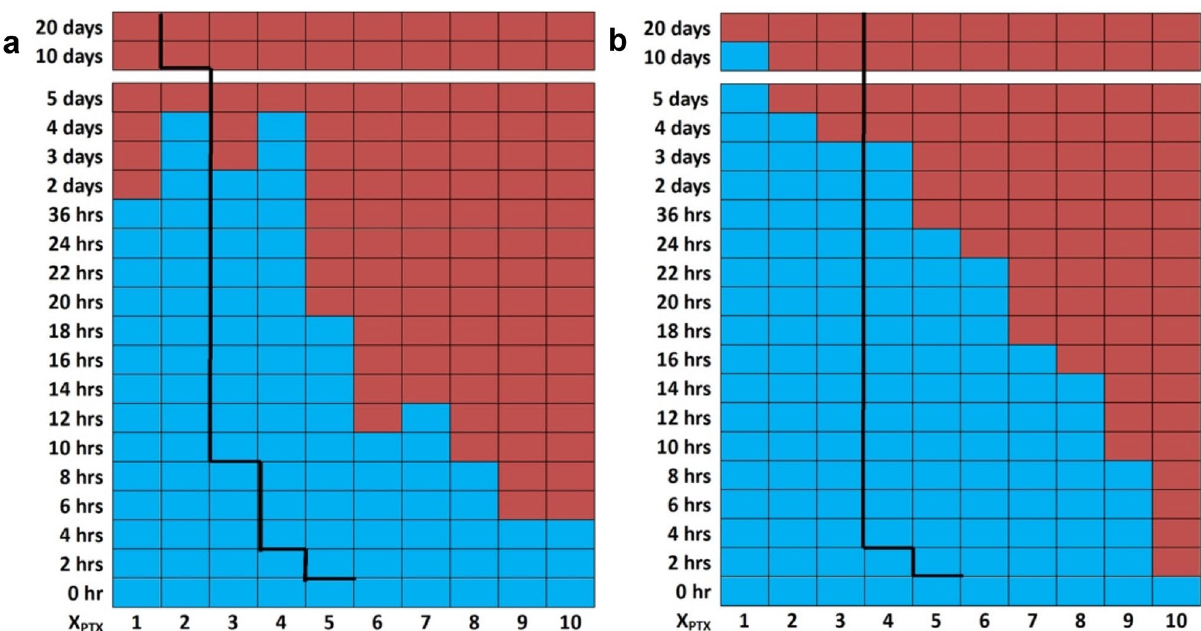
Figure 4. Kinetic phase diagrams of PTX solubility in PTX-loaded CLs with DLin (di-linoleoyl, C18:2) lipid tails (DLinTAP/DLinPC/PTX mole ratio = 50/50–x PTX /x PTX ). DIC microscopy (Fig. 3) was used to detect PTX crystallization at the indicated times after hydration. The blue color indicates absence of PTX crystals (i.e., PTX remained soluble in the membranes), while the red color indicates presence of PTX crystals. The boundary separating the blue region from the red region is termed the PTX membrane solubility boundary. As a reference to facilitate comparison, the black lines show the solubility boundary for PTX-loaded CLs with monounsaturated DO (di-oleoyl, 18:1) tails (DOTAP/DOPC/PTX molar ratio = 50/50-x PTX /x PTX ) 48 . The change in tail structure strongly affects PTX membrane solubility. ( a ) Kinetic phase diagram for sonicated PTX-loaded DLinTAP/DLinPC CLs. ( b ) Kinetic phase diagram for unsonicated PTX-loaded DLinTAP/DLinPC